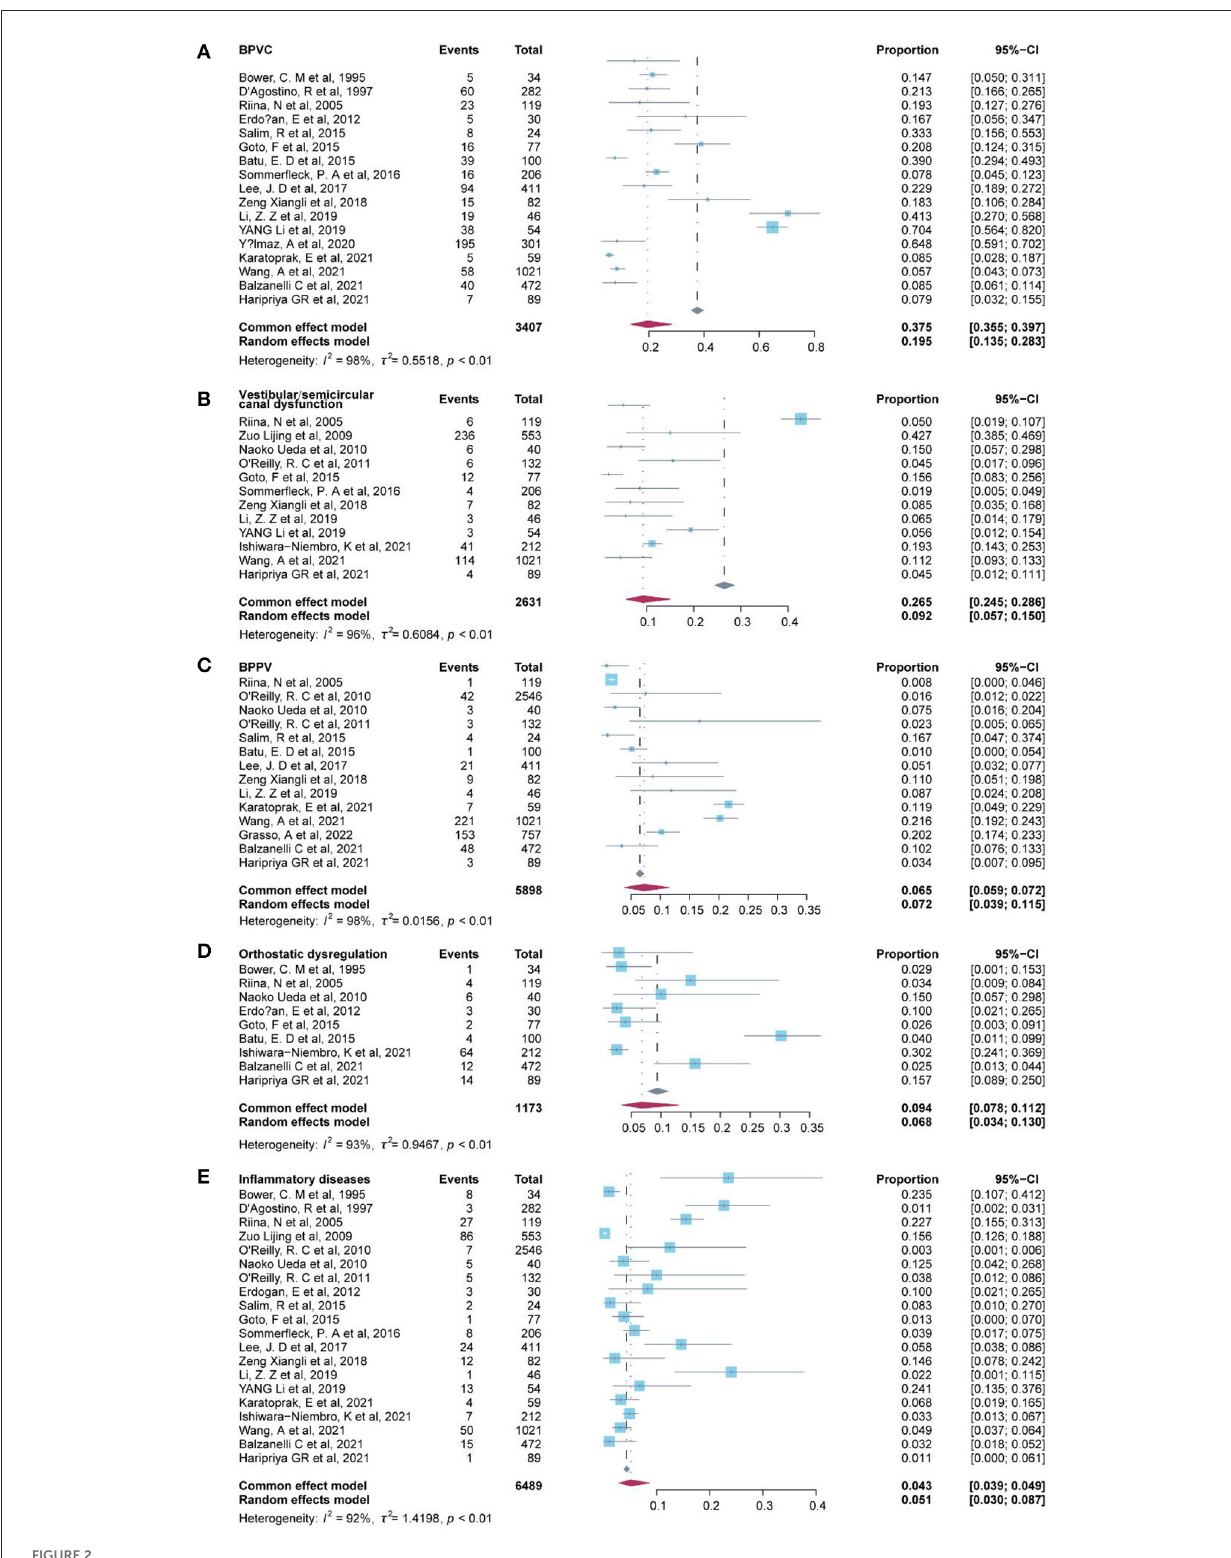
FIGURE2 Forest plot of common diagnosis in peripheral